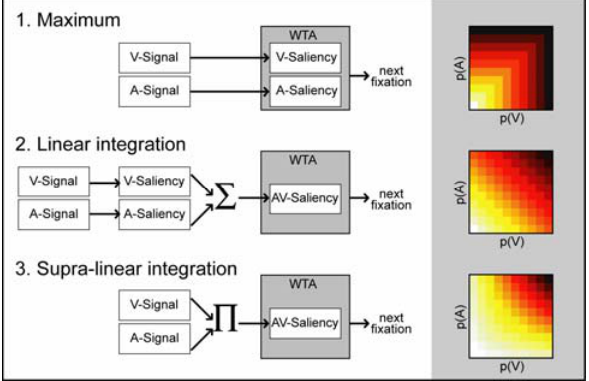
Figure 1. Three hypotheses for audiovisual interaction. The processing leading up to the winner-takes-all selection of the next location to be fixated is shown for each hypothetical integration. The rightmost column (grey background) depicts the corresponding interaction plot for each scheme – visual saliency is plotted on the x-axis, auditory saliency on the y-axis, with colour value (increasing from light to dark) indicating the magnitude of audiovisual saliency for a stimulus region with given visual and auditory saliencies. See text for more